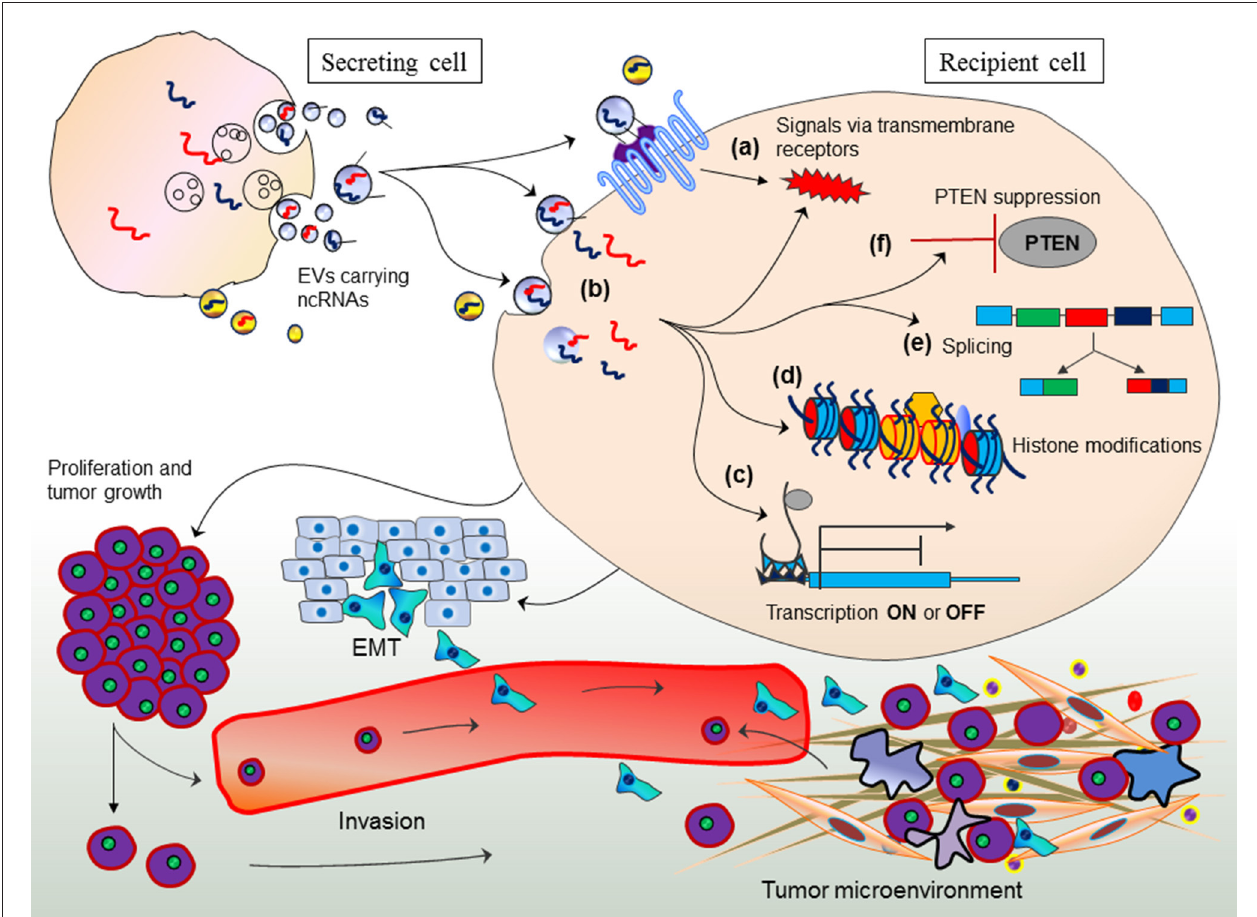
FIGURE 3 | Exosome-mediated trans -regulation between different cell types. Exosomes transfer non-coding RNAs between cells and elicit various mechanisms of trans-regulation between cells. Figure originally adopted from Fatima and Nawaz,